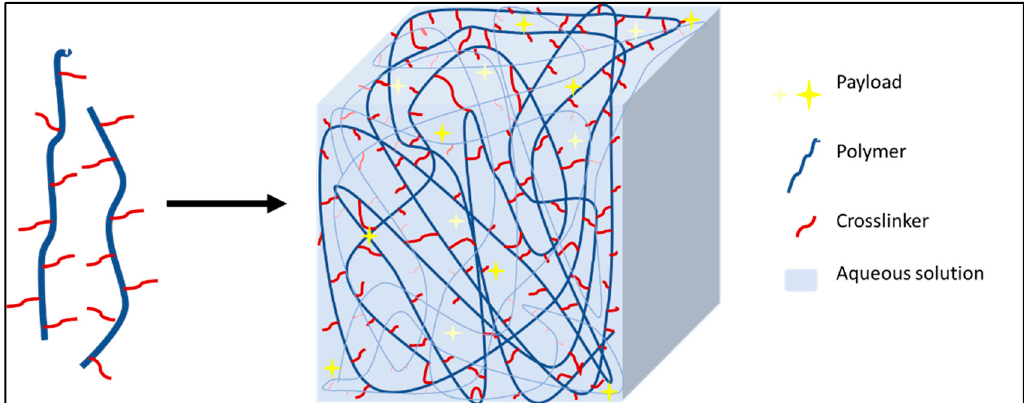
Figure 6. Nanohydrogel matrices are formed by polymers that can form the 3D network with the help of crosslinkers (red) that act as linking ligands. The payloads (yellow star) can be trapped inside the 3D matrix.